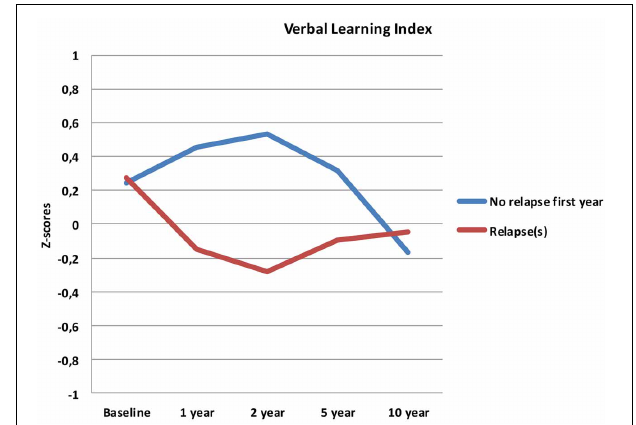
FIGURE 2 | Verbal Learning index from baseline to 10 year follow-up, split by early relapse.